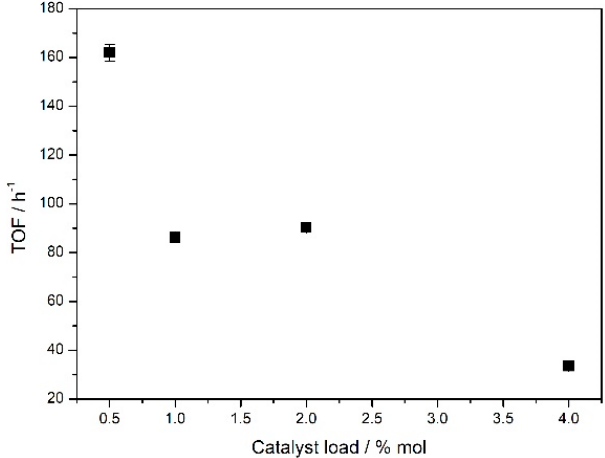
Figure 2. Dependence of turnover frequencies (TOF) values (h − 1 ) in function of catalyst load (% mol). Reaction conditions: 0.5%, 1.0%, 2.0%, and 4.0% mol catalyst ( Fe5F ), 0.2 mmol of benzaldehyde, 0.6 mmol of TEOF, and 12 mmol of ethanol at 70 °C, under magnetic stirring.